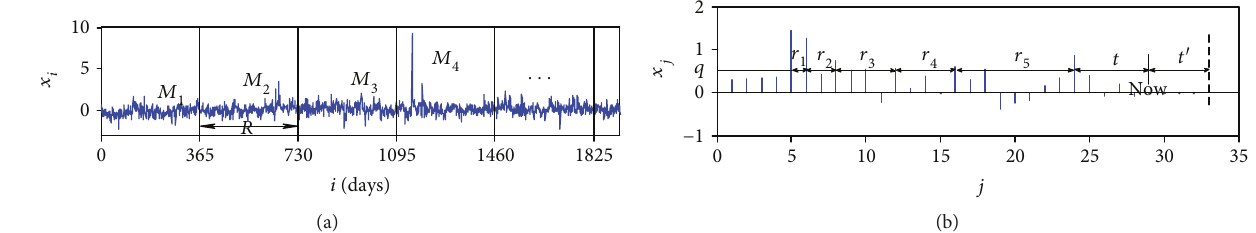
Figure 1: (a) Illustration of maxima series M the maximum value of the i th interval. (b) De fi nition of the return interval r is the distance between two adjacent events that exceed the threshold q . The black dotted line in (b) represents the next unknown events that exceed the threshold q at the moment of “ NOW ” ; t is the elapsed time since the last event; and t ′ is the residual waiting time to the next extreme